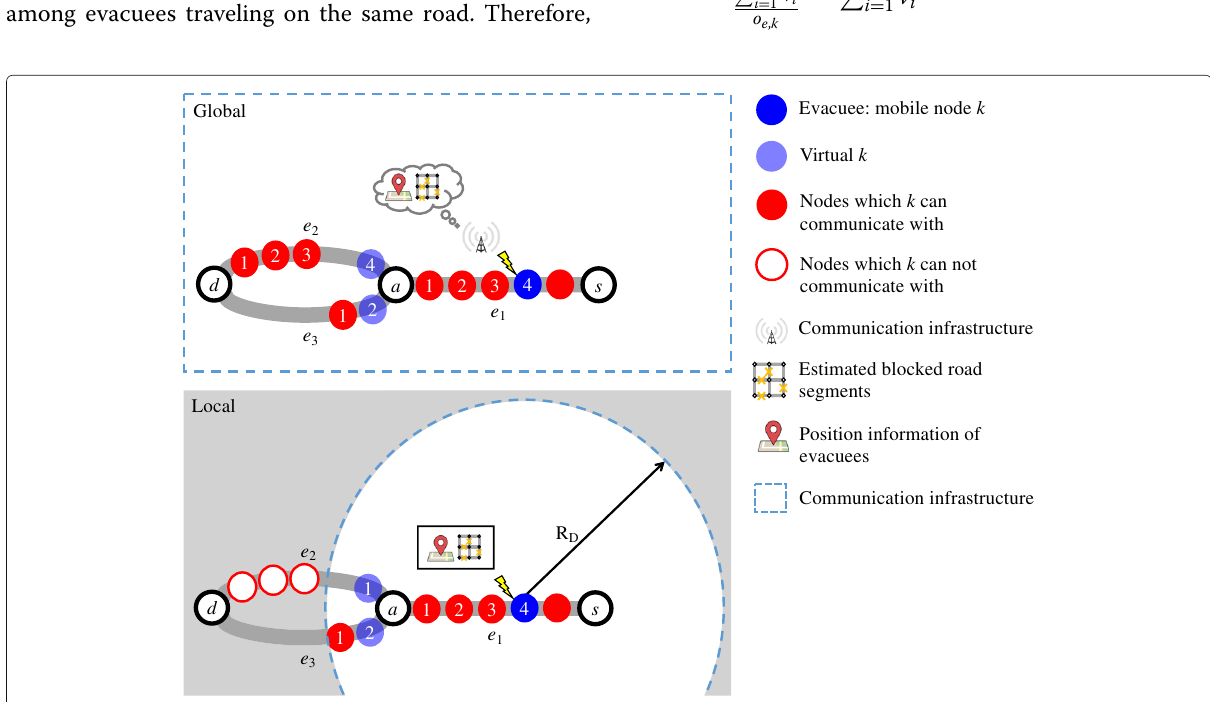
Fig. 3 Information retrieval of congestion-aware route